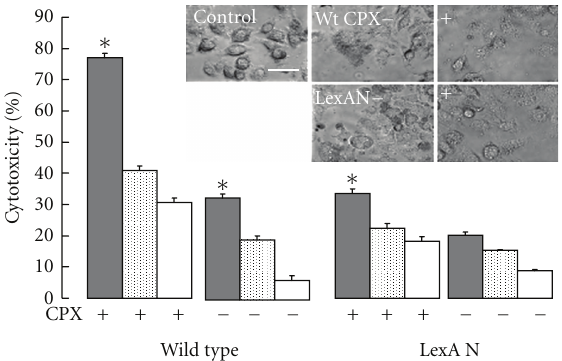
Figure 4: OMV-mediated macrophage cytotoxicity is SOS depen- dant. OMVs isolated from the wild-type (wt) and the LexA noncleavable ( lexAN ) cells as indicated were incubated with macrophage. Top: phase-contrast microscopy of macrophage incu- bated with OMVs at 1.3 μ g/mL after a 1hr incubation. Bar, 20 μ m. Bottom: cytotoxicity was measured as the levels of released cytosolic lactate dehydrogenase after 4hr incubation. It was set 0 for the macrophage-only control. OMV concentrations: grey, 1.3 μ g/mL; doted, 0.65 μ g/mL; blank, 0.325 μ g/mL. ( ∗ P < 0 . 05, n = 4)